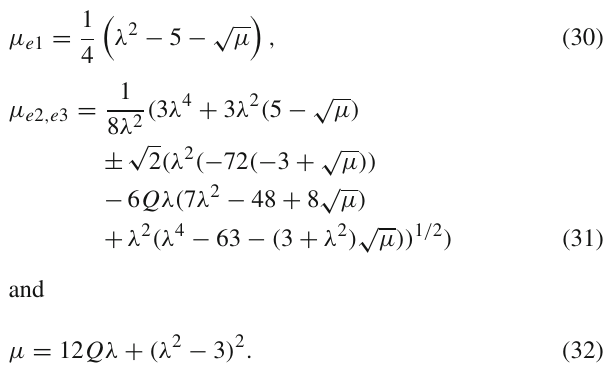
See the main text Saddle or